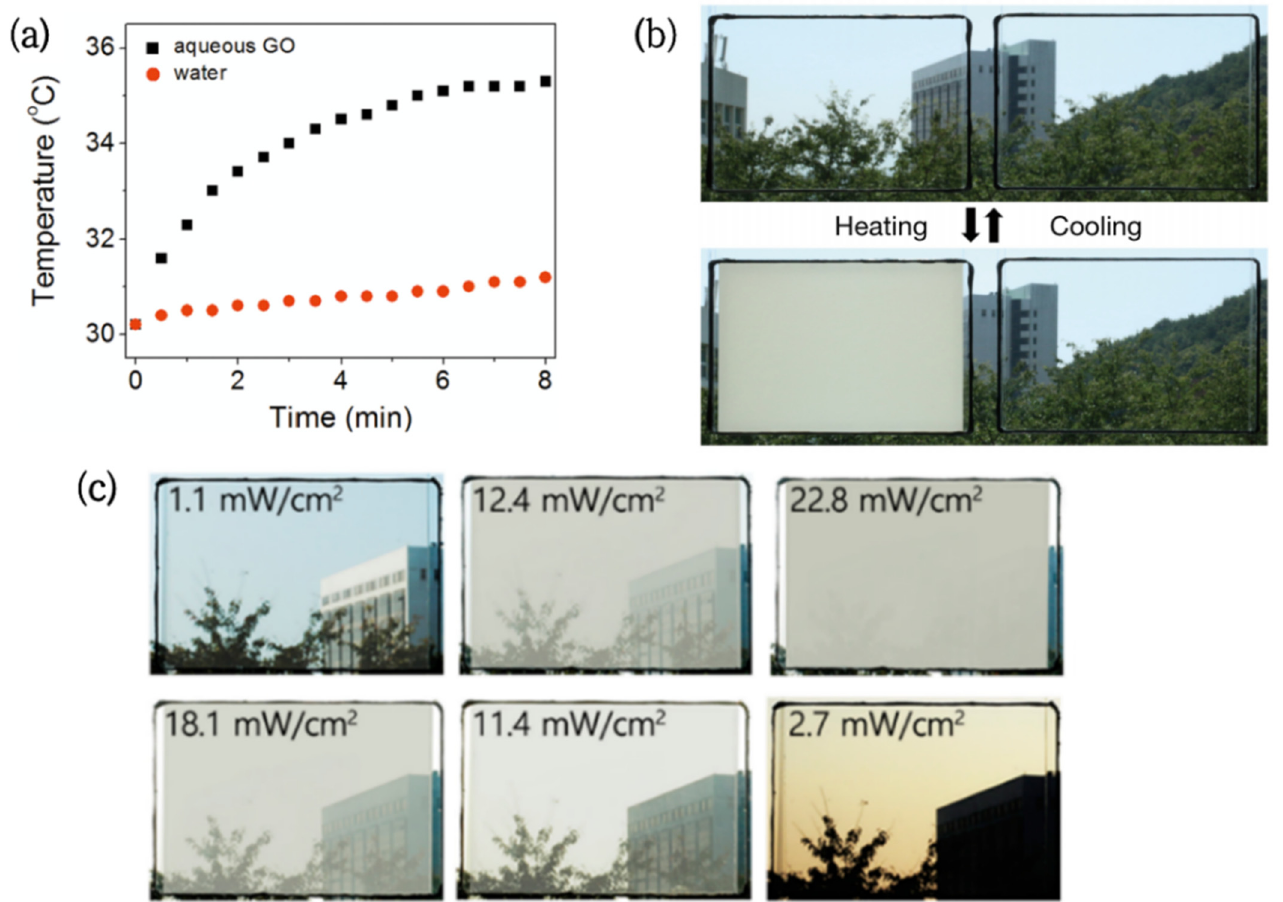
Figure 2. ( a ) Temperature change of pure water and 2.5 mg/mL GO aqueous solution under visible light irradiation [49]. ( b ) Photo of the transparency transition of PNIPAMm/GO hydrogel window (left) and PNIPAm hydrogel window (right) under sunlight [41]. ( c ) Photo of the PNDV/GO hydrogel window transmittance gradient change with light intensity [43].